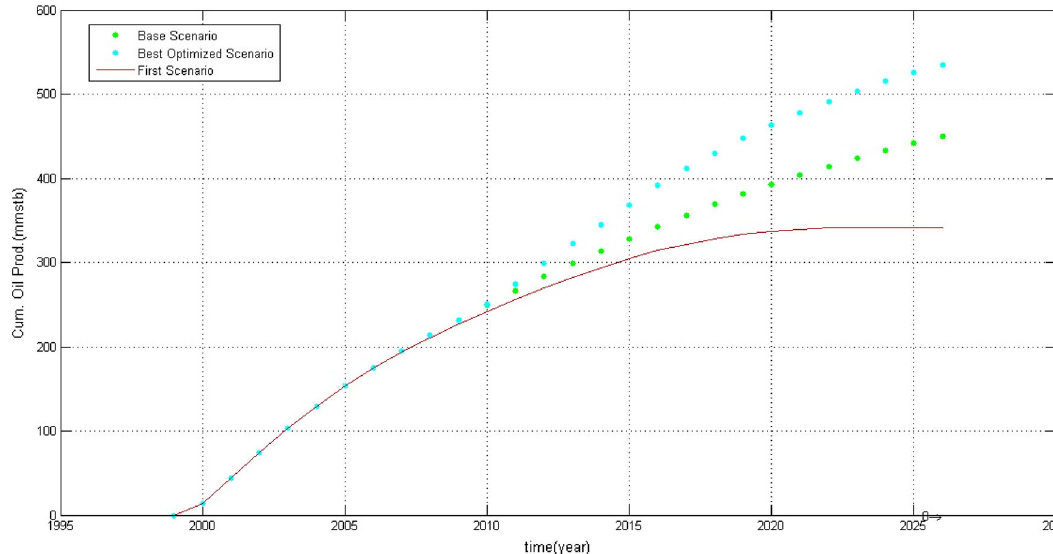
Fig. 2 Cumulative oil production of first scenario